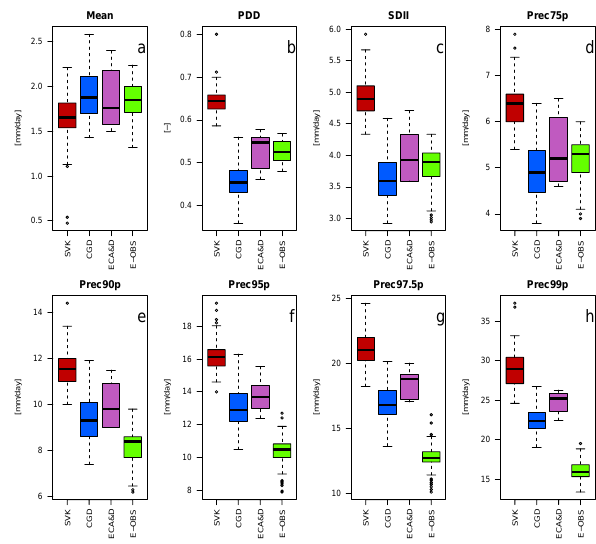
Fig. 3. Box plots summarising the mean precipitation (Mean) (a) , the proportion of dry days (PDD) (b) , the mean precipitation amount per wet day (SDII) (c) , and different percentiles of extreme precipitation (Prec75p to Prec99p) (d–h) for the four observational data